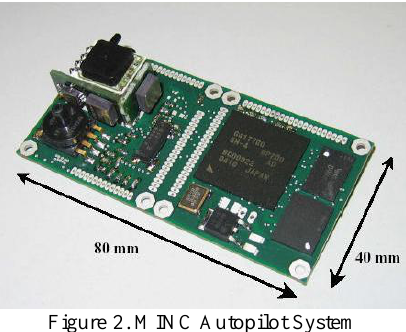
Figure 2. MINC Autopilot System